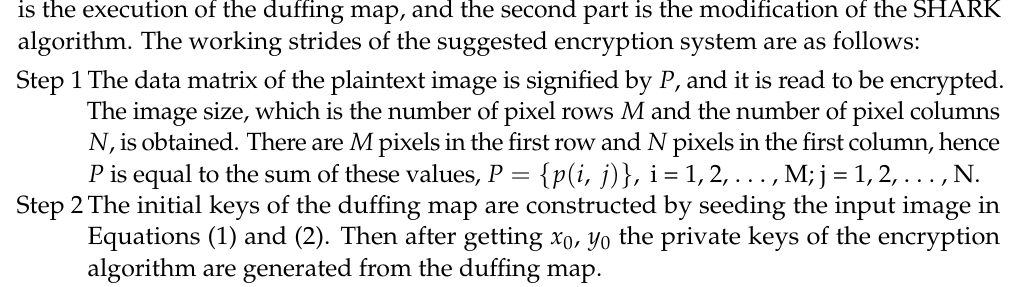
Table 1. NIST randomness measure for Duffing map chaotic sequences.